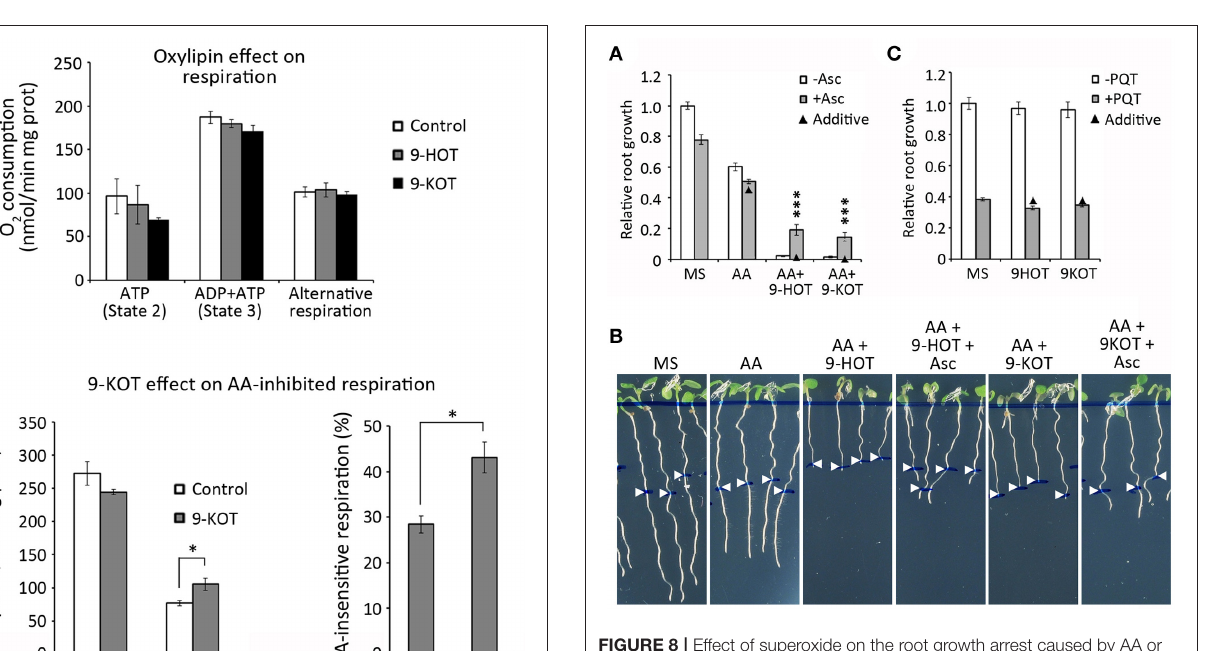
FIGURE 8 | Effect of superoxide on the root growth arrest caused by AA or AA/oxylipin combinations. (A) Relative root growth of wild type plants grown for 4 days on MS and then transferred to MS with AA, AA/9-HOT, and AA/9-KOT, with or without the superoxide scavenger Ascorbate (500 µ M). (B) Representative images of plants from (A) . (C) Relative root growth of wild type plants in MS, 9-HOT or 9-KOT, with or without addition of the superoxide generator Paraquat (2nM). In (A,B) , AA concentration was 2.5 µ M. In all cases, 9-HOT and 9-KOT concentration was 12.5 µ M. Black triangles represent expected root growths in combined treatments if both effects were additive (no interaction). Asterisks represent a significant interaction between treatments ( n ≥ 8, Two way ANOVA, *** P <